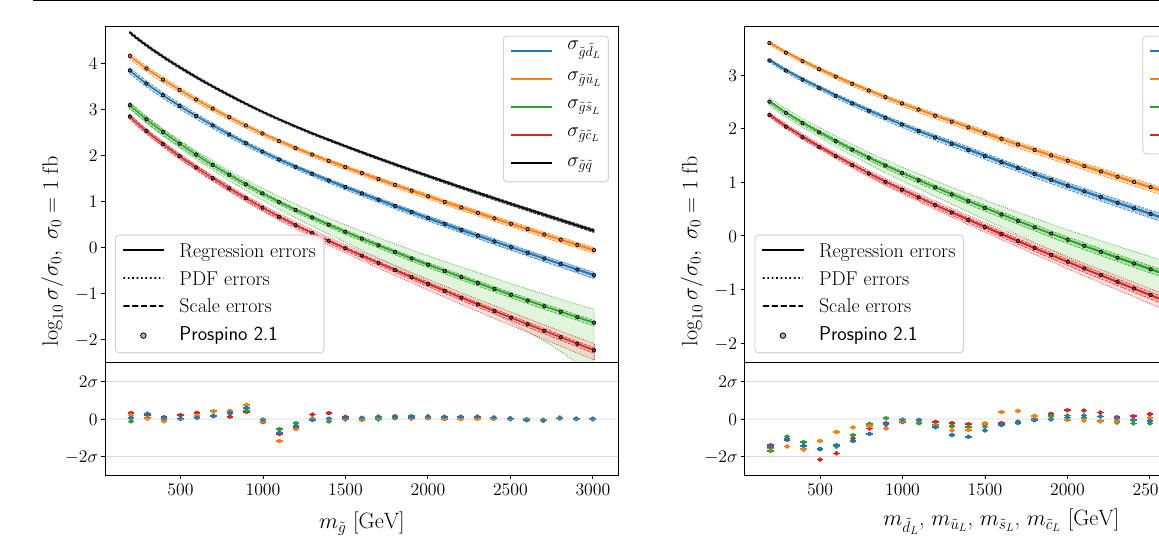
In the right-hand plot all masses except for the final-state squark mass are fixed at 1TeV. The central-value xsec prediction is shown with error bands from regression (solid line), scale error (dashed) and PDF error (dotted). The α s error is too small to be visible. Also shown are the Prospino values (dots)